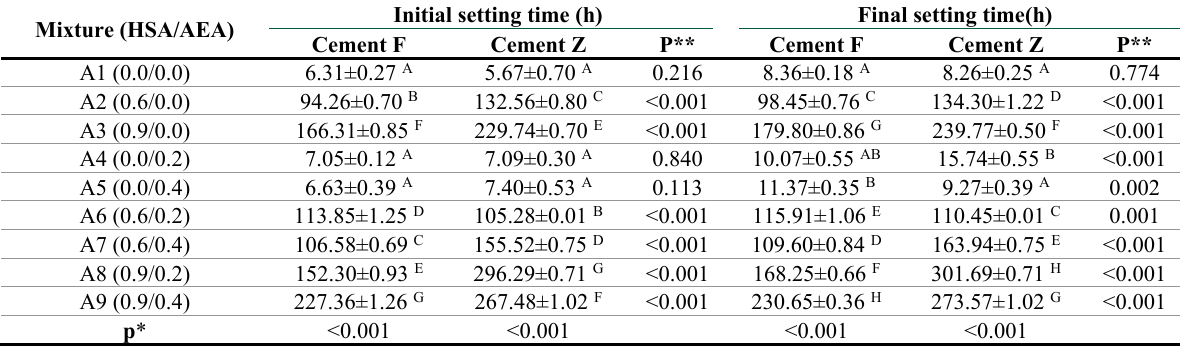
Mixture (HSA/AEA)